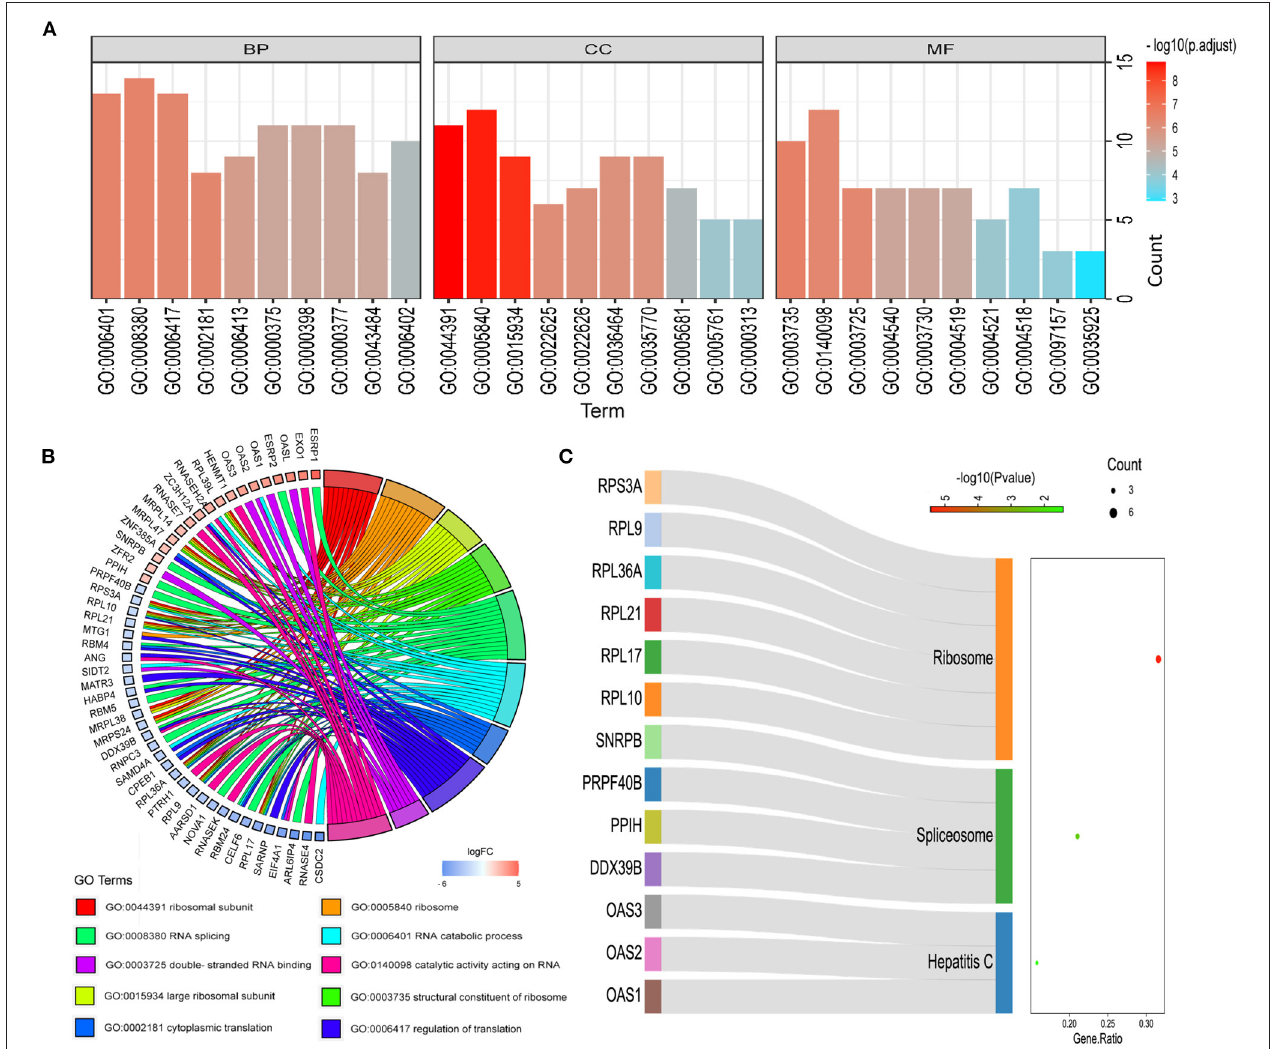
FIGURE 3 | Functional enrichment analysis of differentially expressed RBPs. (A) GO analysis divided RBPs into three functional groups: biological process (BP), cell composition (CC) and molecular function (MF). (B) Distribution of RBPs in the first 10 GO enrichment functions. (C) KEGG analysis of differentially expressed RBPs.